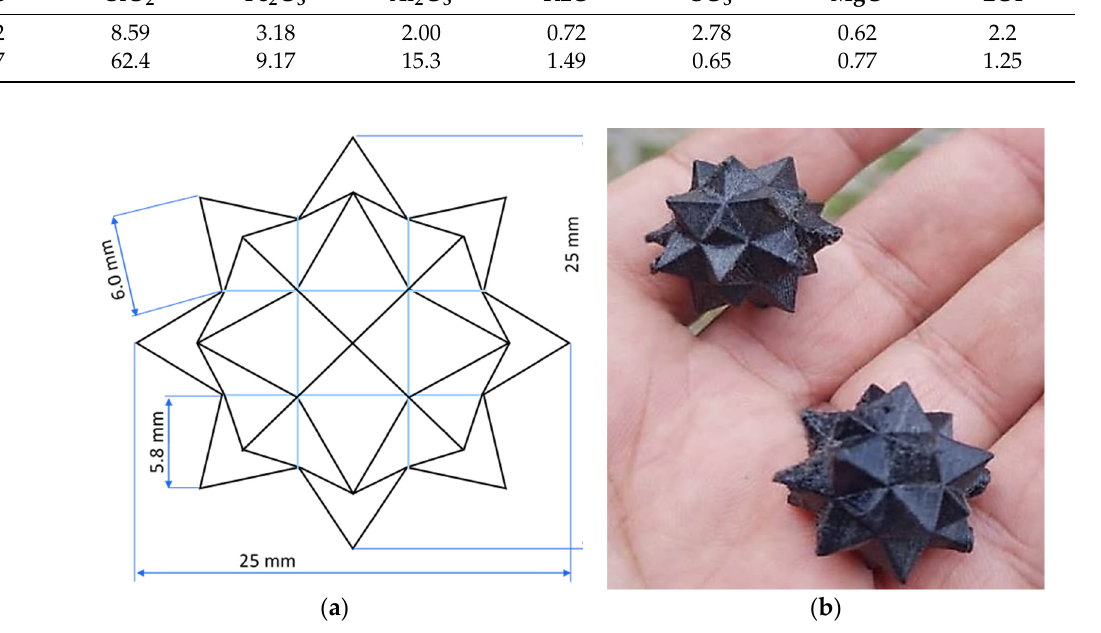
Figure 3. ( a ) A schematic diagram of the OBA showing its dimensions; ( b ) The 3D printed OBAs.